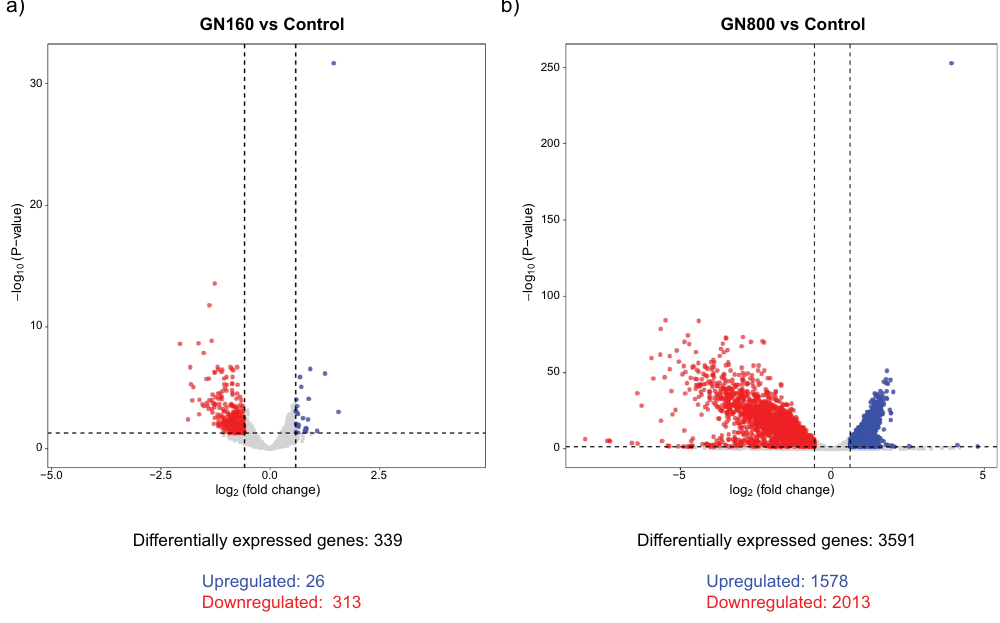
Figure 5. Volcano plots displaying the amount of differentially expressed genes and fold change (log 2 ) in expression levels in GN160 (a) and GN800 (b) conditions when compared to the control condition. Genes were considered differentially expressed if FC > 1.5 (upregulated) or FC < 1/1.5 (downregulated) and false discovery rate (FDR) was lower than